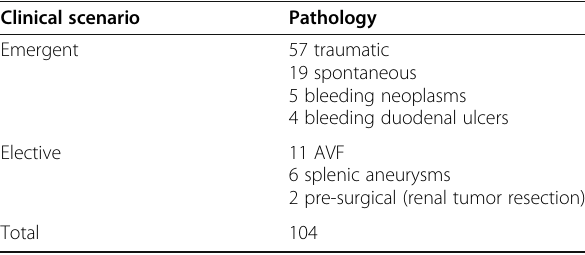
Table 2 Underlying pathologies according to emergent and clinical